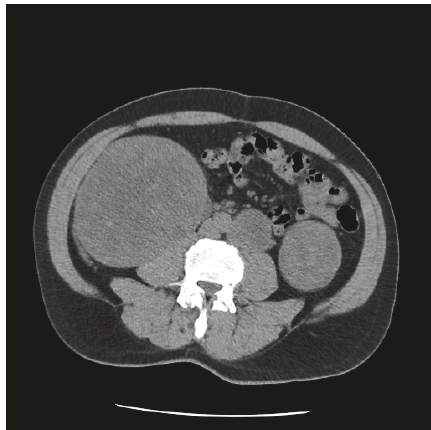
Figure 1: Computed tomography without contrast revealed a large right renal mass with significant mass effect on the right kidney.Adjacentsofttissuenodularitieswereconcerningforsatellite nodules or metastatic disease.